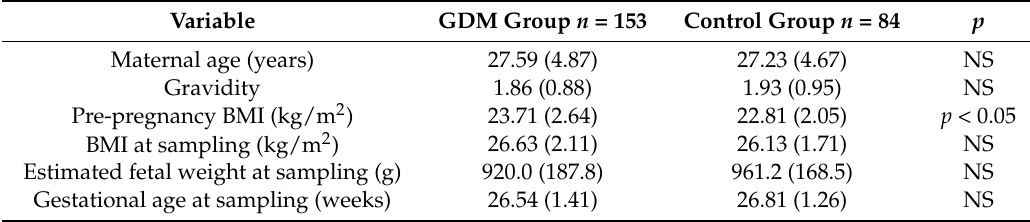
Table 1. Characteristics of the study population (mean and standard deviation). Variable